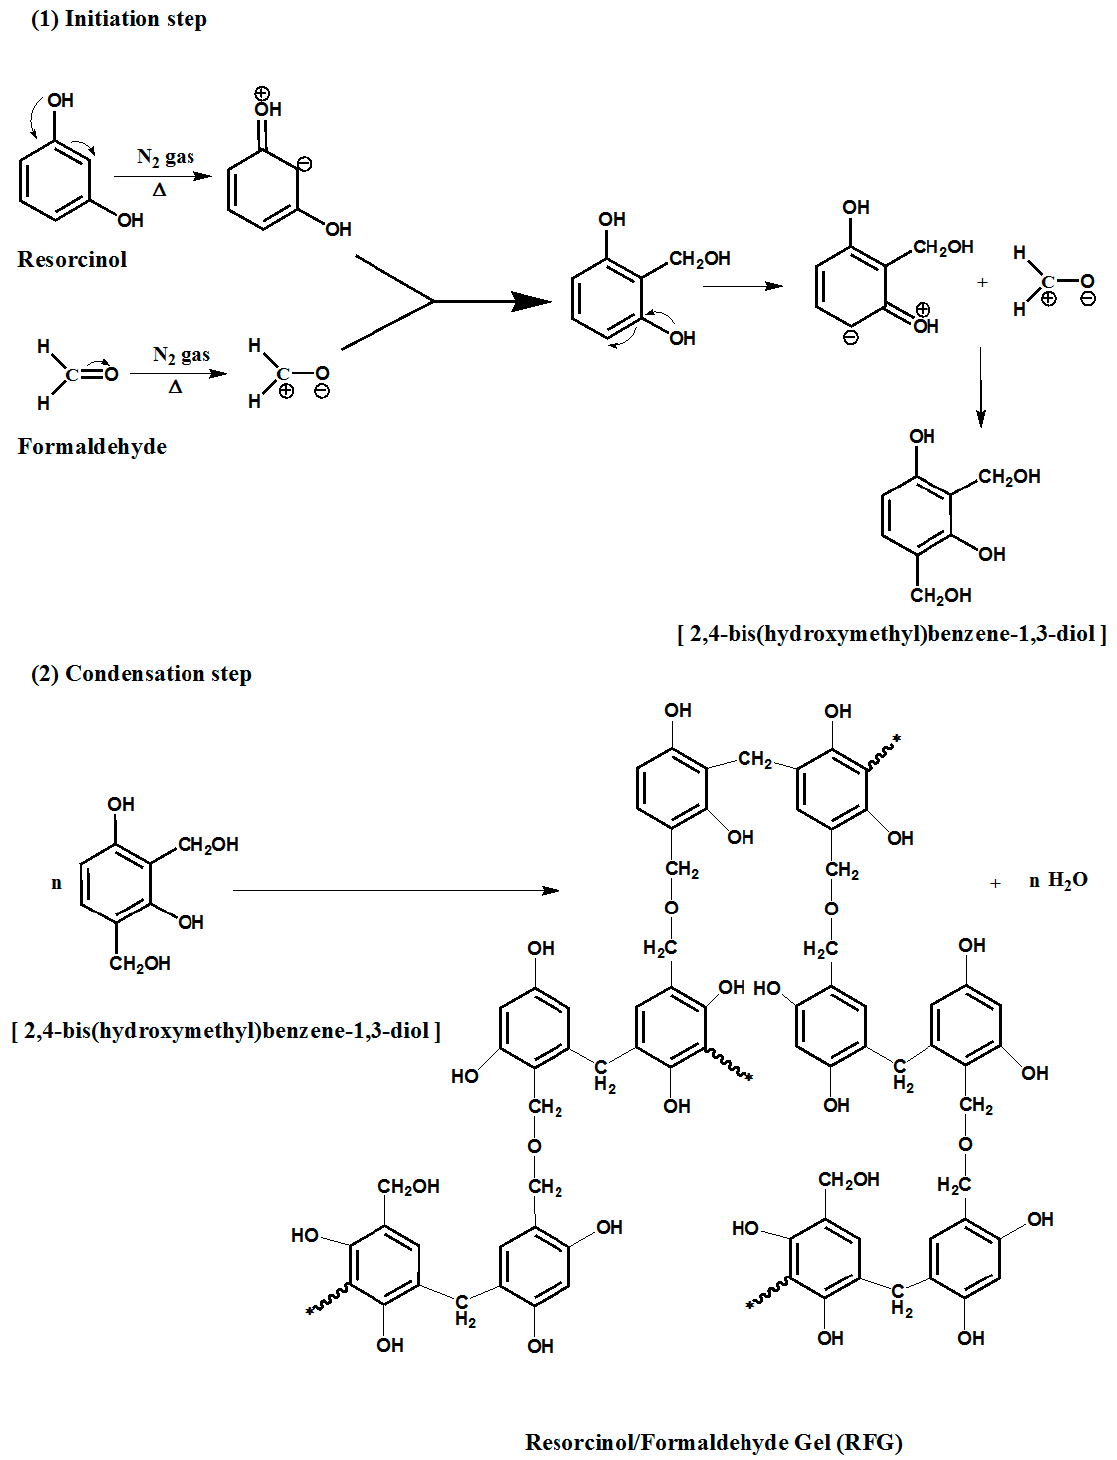
Figure 2. A proposed reaction mechanism of the novel thermal approach to crosslink resorcinol and formaldehyde to form RFG. formaldehyde to form